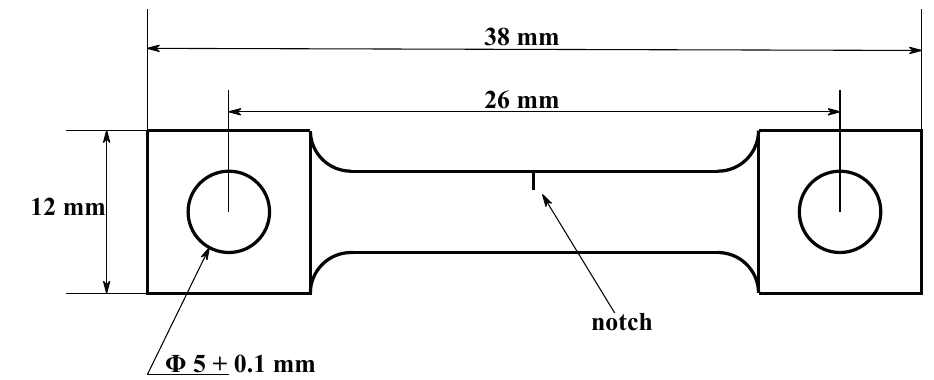
Figure 2. Dimensions of the fracture toughness specimen.